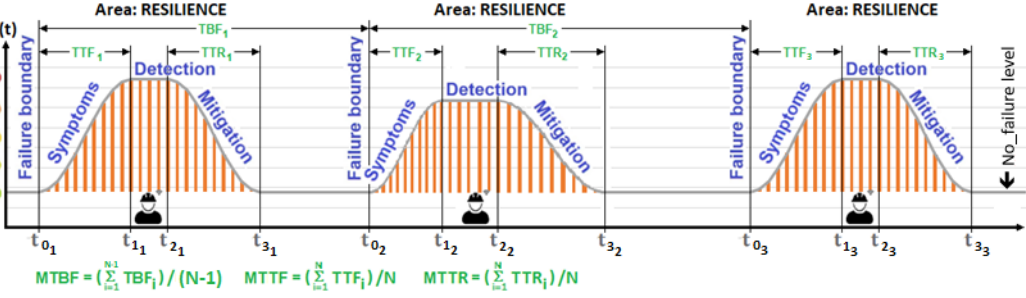
Figure 12. MTBF, MTTF and MTTR maintenance metrics.